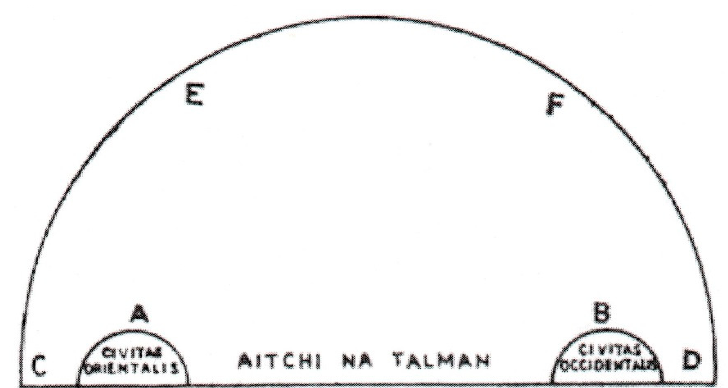
Figure 2. Flat Earth showing places in the east ( A ) and west ( B ). (Reproduced from Williams [5]) .